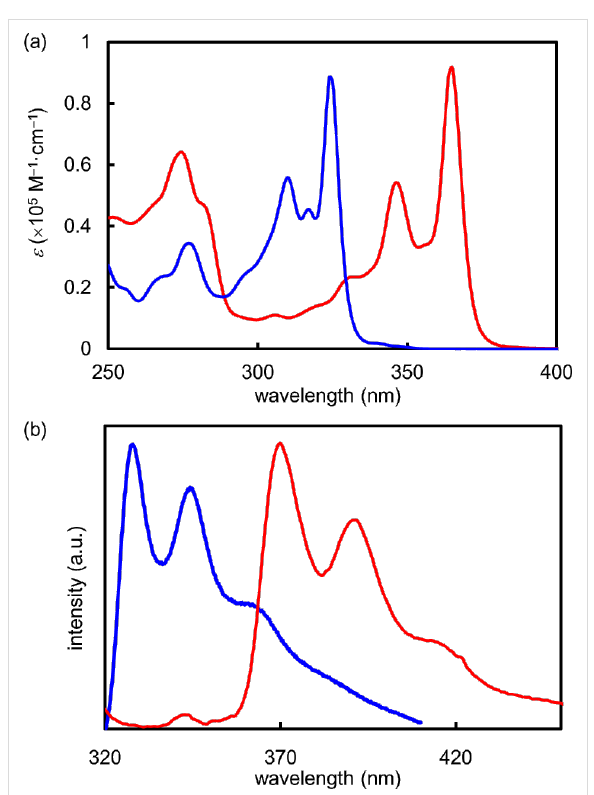
Figure 3: (a) UV–vis absorption spectra of syn -DBBDF 5 (blue line) and syn -DNBDF 6 (red line) in CHCl 3 (1.0 × 10 − 5 M) and (b) normal- ized photoluminescence spectra of syn -DBBDF 5 (blue line) and syn -DNBDF 6 (red line) in CHCl 3 (1.0 × 10 − 7